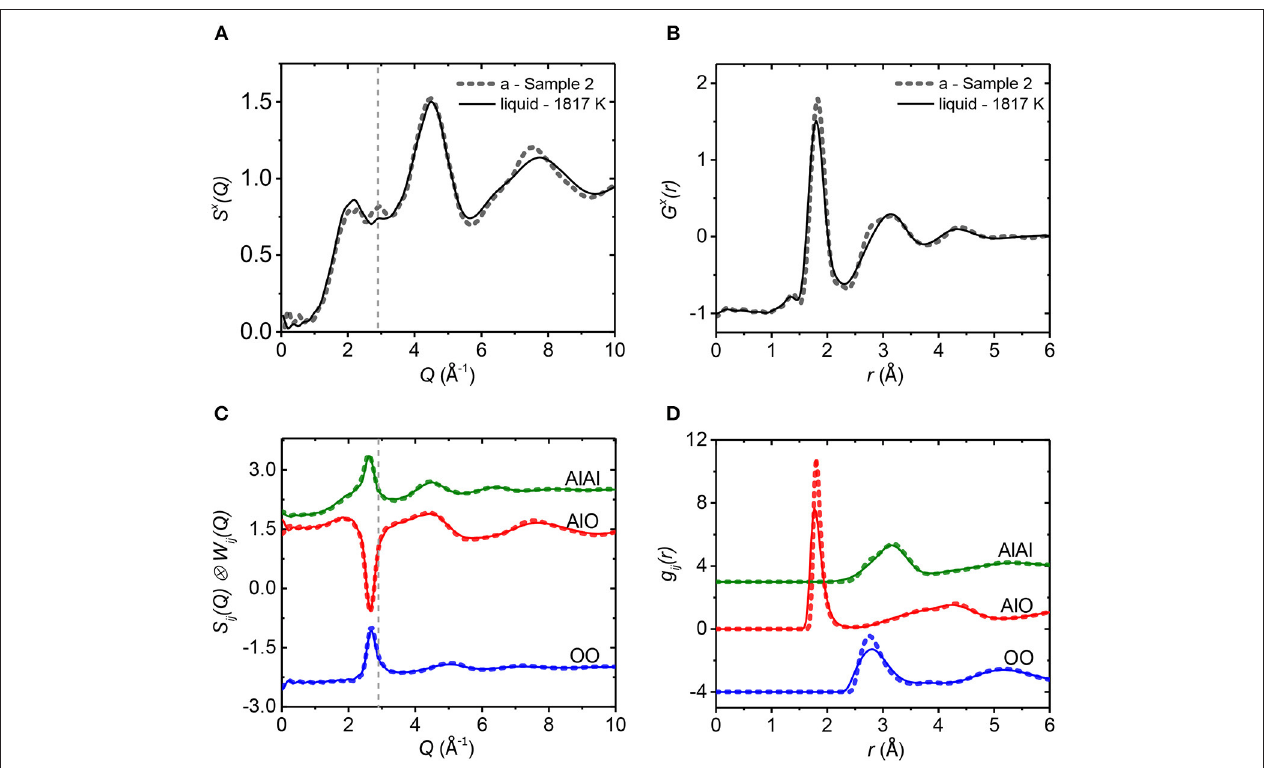
FIGURE 7 | Comparison of amorphous Al 2 O 3 (Sample 2, dotted lines) to supercooled liquid Al 2 O 3 at 1,817K (solid lines). The total (A,B) and partial (C,D) x-ray structure factors S(Q) (A,C) and pair distribution functions G(r) (B,D) from EPSR are shown. Note that the S ij ( Q ) in part (C) have been multiplied by the x-ray pair weighting factors, W ij ( Q ). Vertical offsets have been applied for